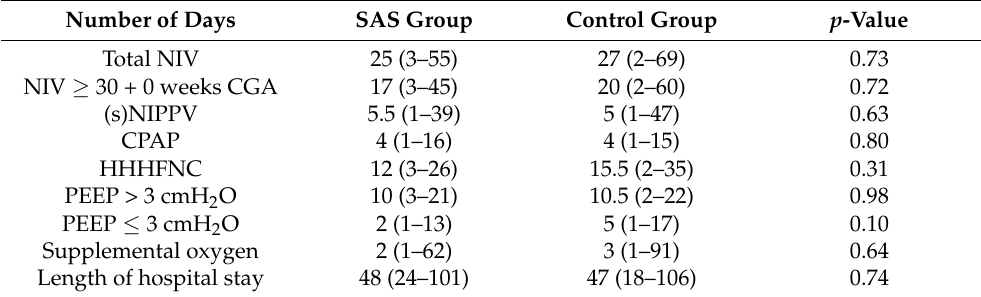
Table 2. NIV outcome parameters.